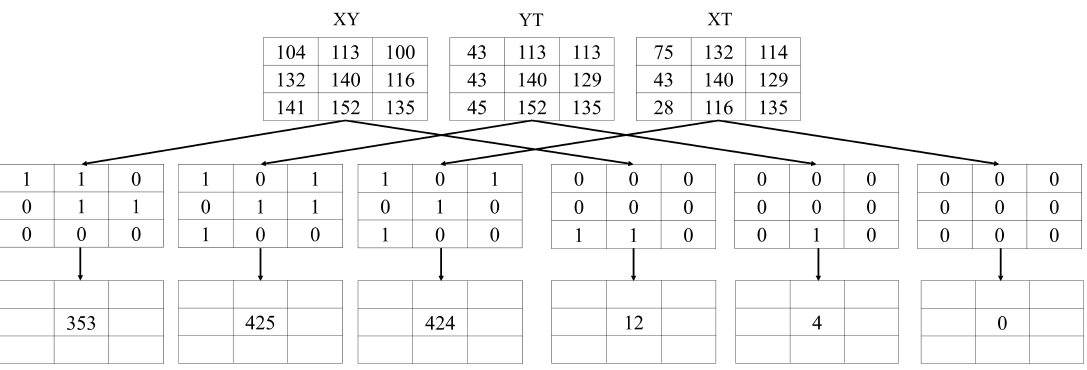
Figure 7. Illustration of local directional ternary pattern–three orthogonal planes